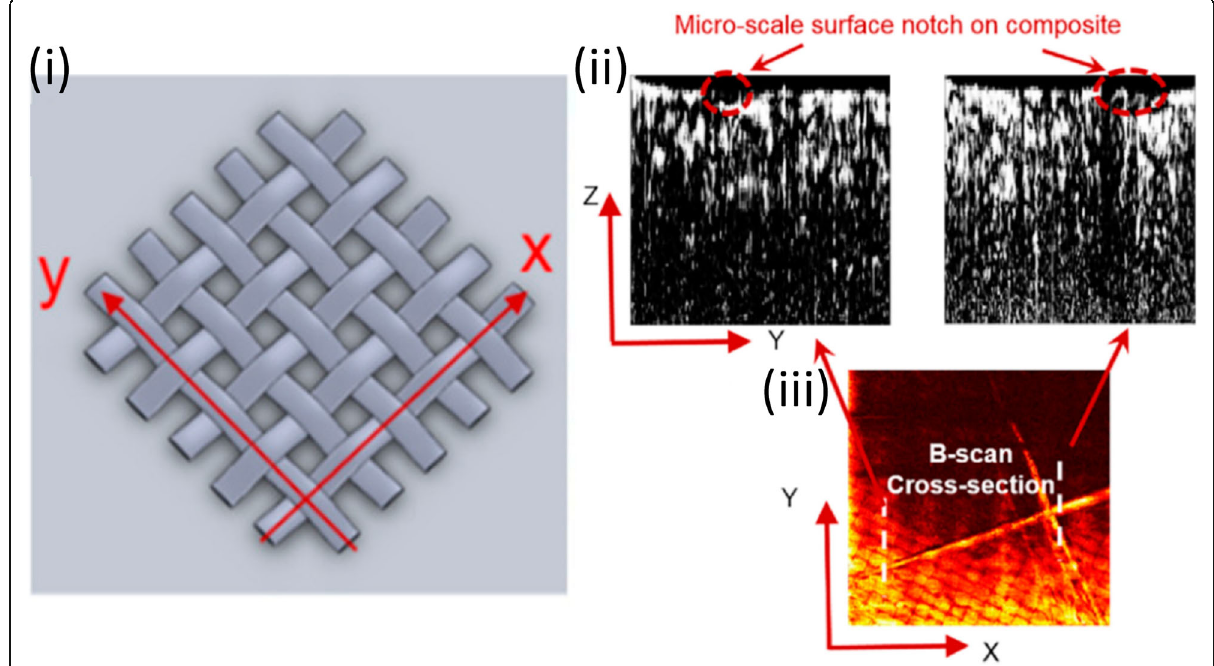
Fig. 4 One representative application of composite using PA technologies for NDT/E: Detection of damage in CFRP composites [9]. ( a ) : Illustrative image of grid pattern; ( b ): B-scan images; and ( c ) : C-scan image (bottom). The B-scan images are along the white lines in the C-scan